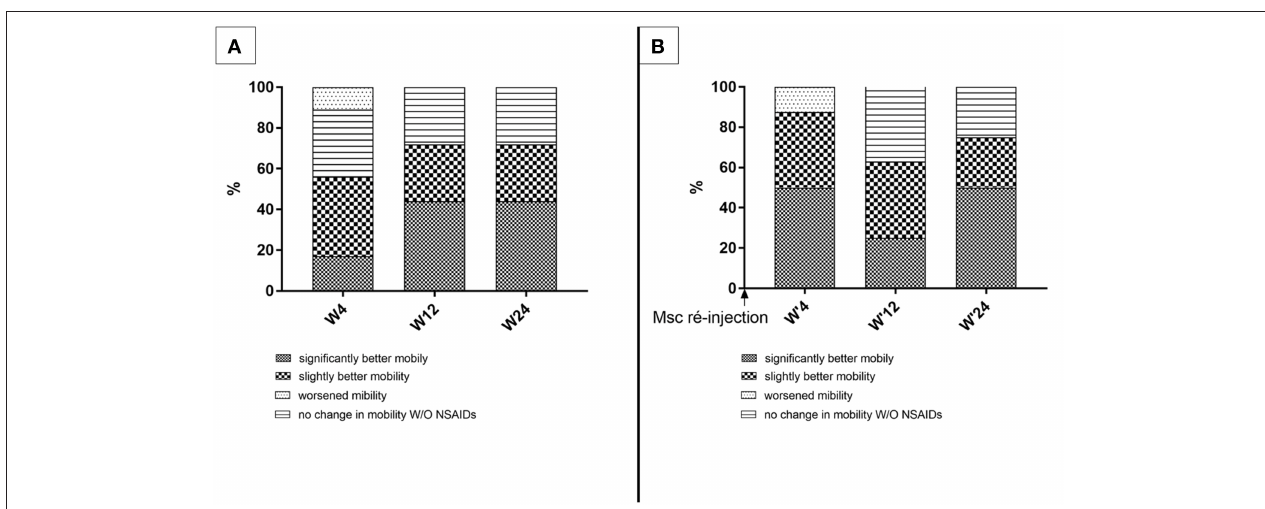
FIGURE 5 | Owner’s evaluation of dog’s mobility. These figures show the owner’s satisfaction (A) following the first injection ( n = 16 dogs); (B) following the second injection ( n = 8 dogs).